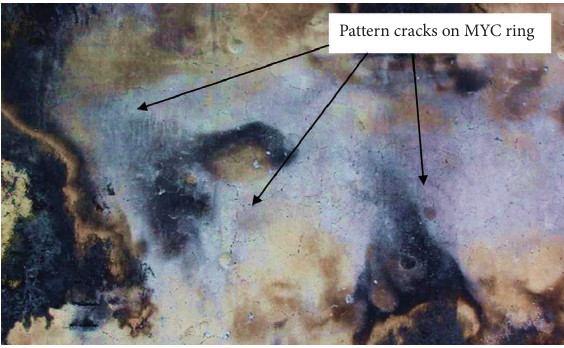
Figure 10: Cracking on the MYC